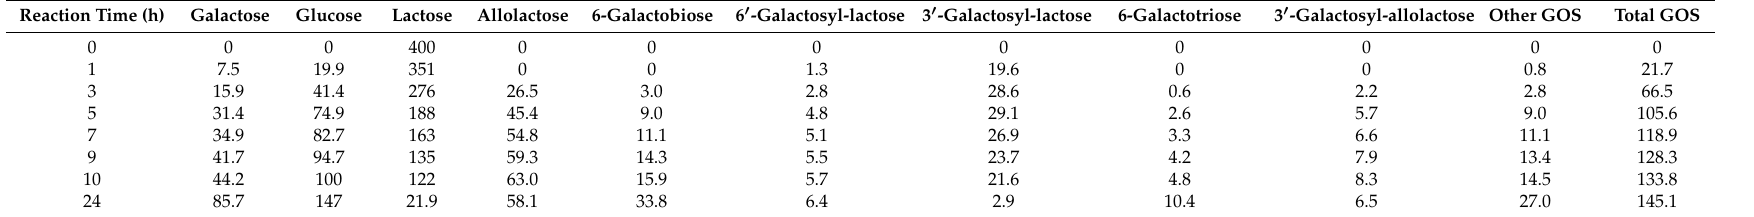
Table 2. Carbohydrate composition (g/L) of the reaction mixture using P. anthophila Bac 69.1 permeabilized cells as a biocatalyst a